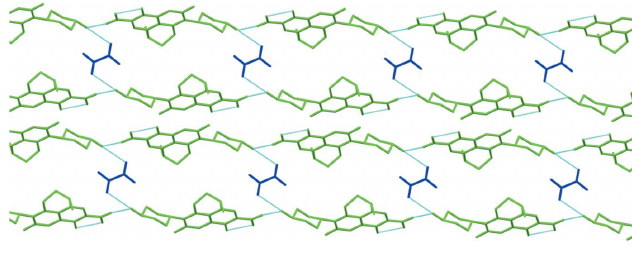
Figure 3 Two ribbons of NAD and OA formed by hydrogen bonds.